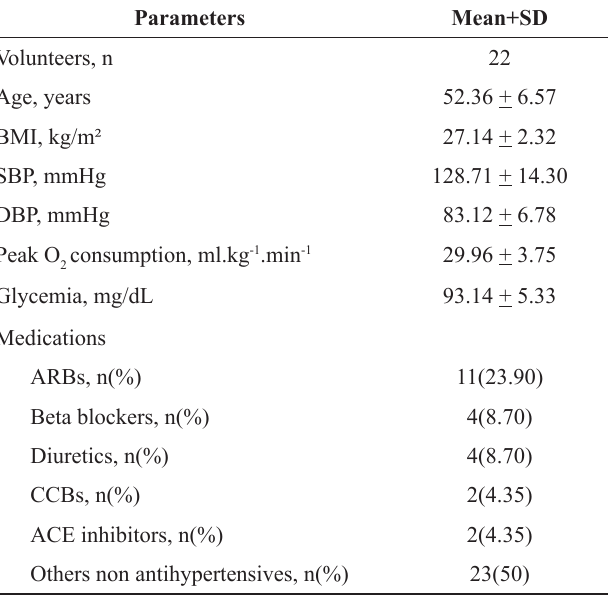
Table 1. General characteristics of the volunteers Parameters